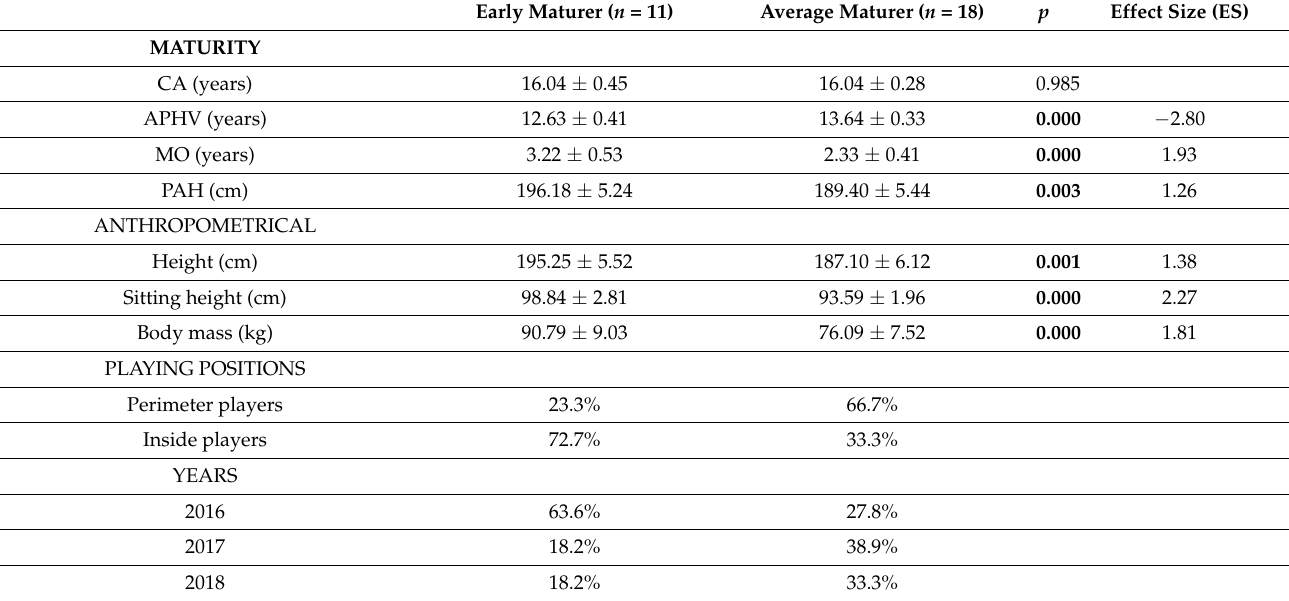
Table 1. Between-group comparisons in the maturity, anthropometrical, and training variables based on the maturity timing (Mean ±